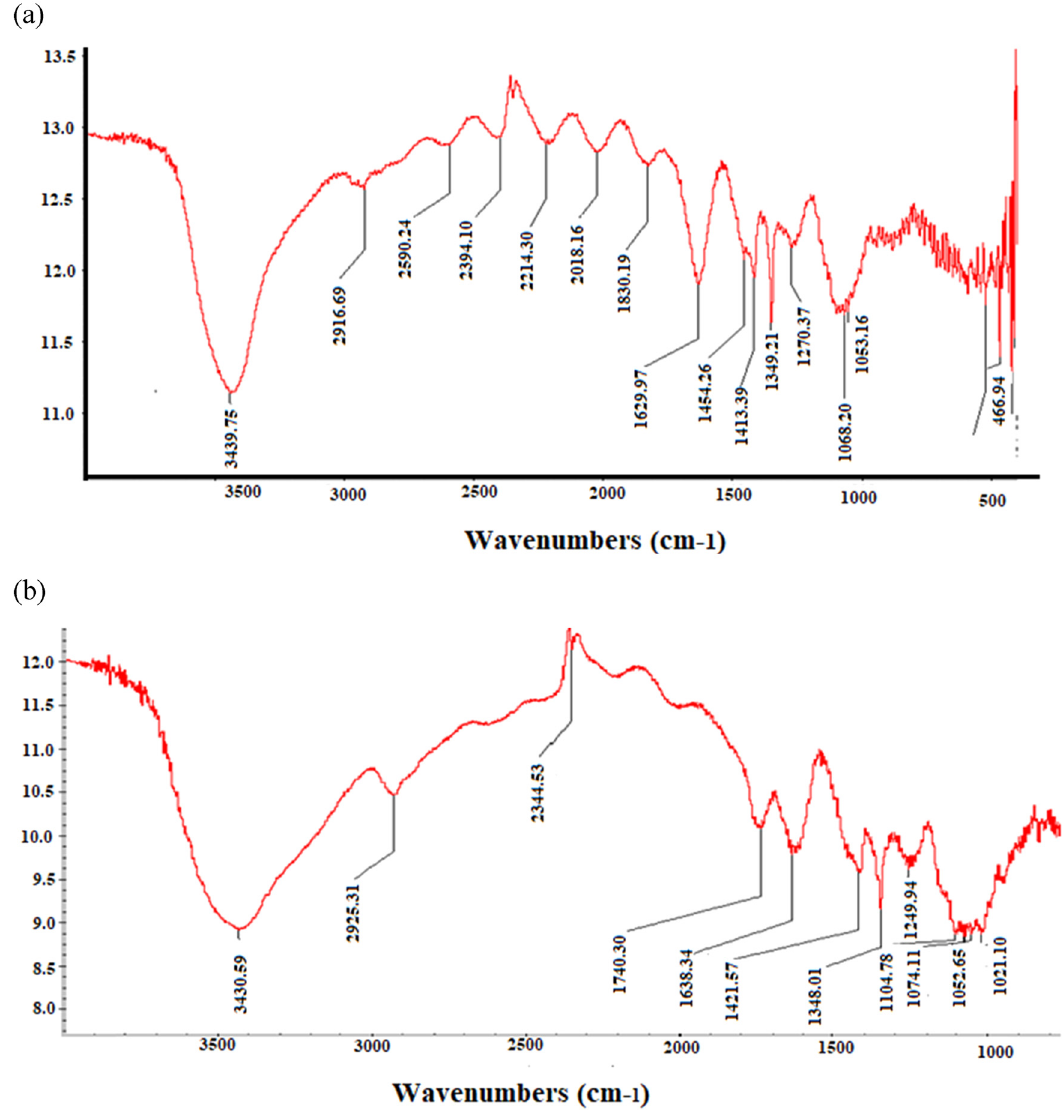
Figure 6: IR spectra of ( a ) A. digitata extract and ( b ) green - synthesized A. digitata